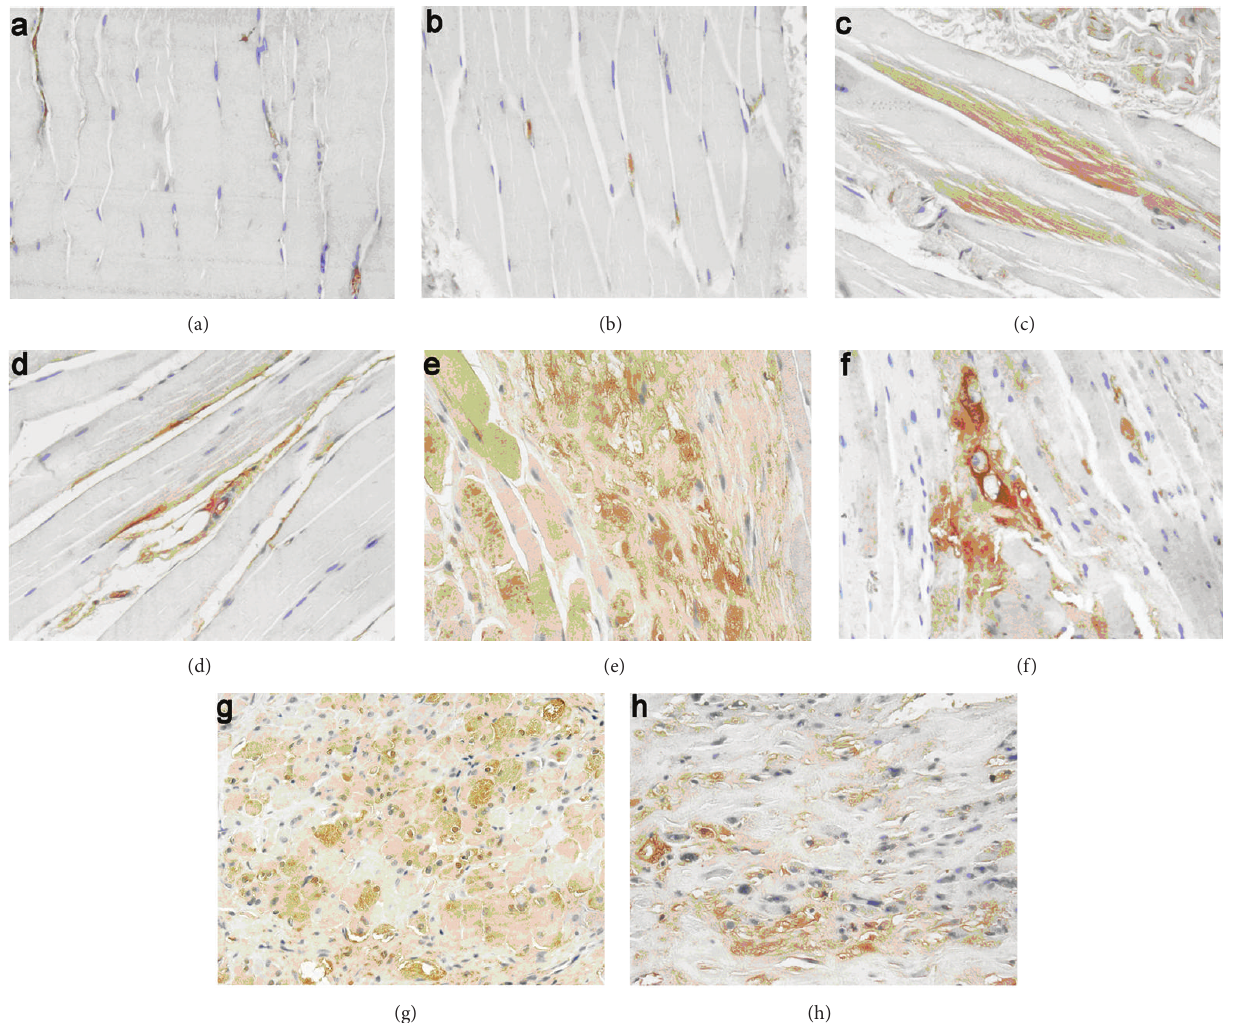
Figure 6: IHC analysis of TGF- 𝛽 1 in muscle tissue at different time points after irradiation ( × 200). No significant expression of TGF- 𝛽 1 was noted in the PBS group (a) and ASCs group (b) at 1 w after irradiation. The expression of TGF- 𝛽 1 increased gradually in both PBS group (c, e, and g) and ASCs group (d, f, and h) at 4 w, 8 w, and 26 w; however, the expression of TGF- 𝛽 1 in ASCs group was lower than those of PBS group at the same time point after